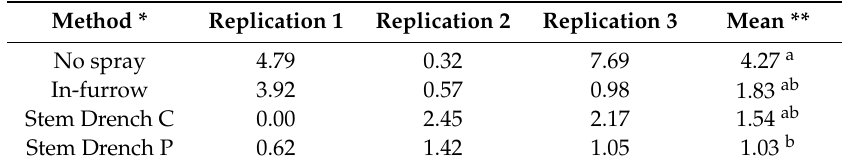
Table 4. E ff ect of Topguard Terra application method on CRR (% mortality) in the 2018